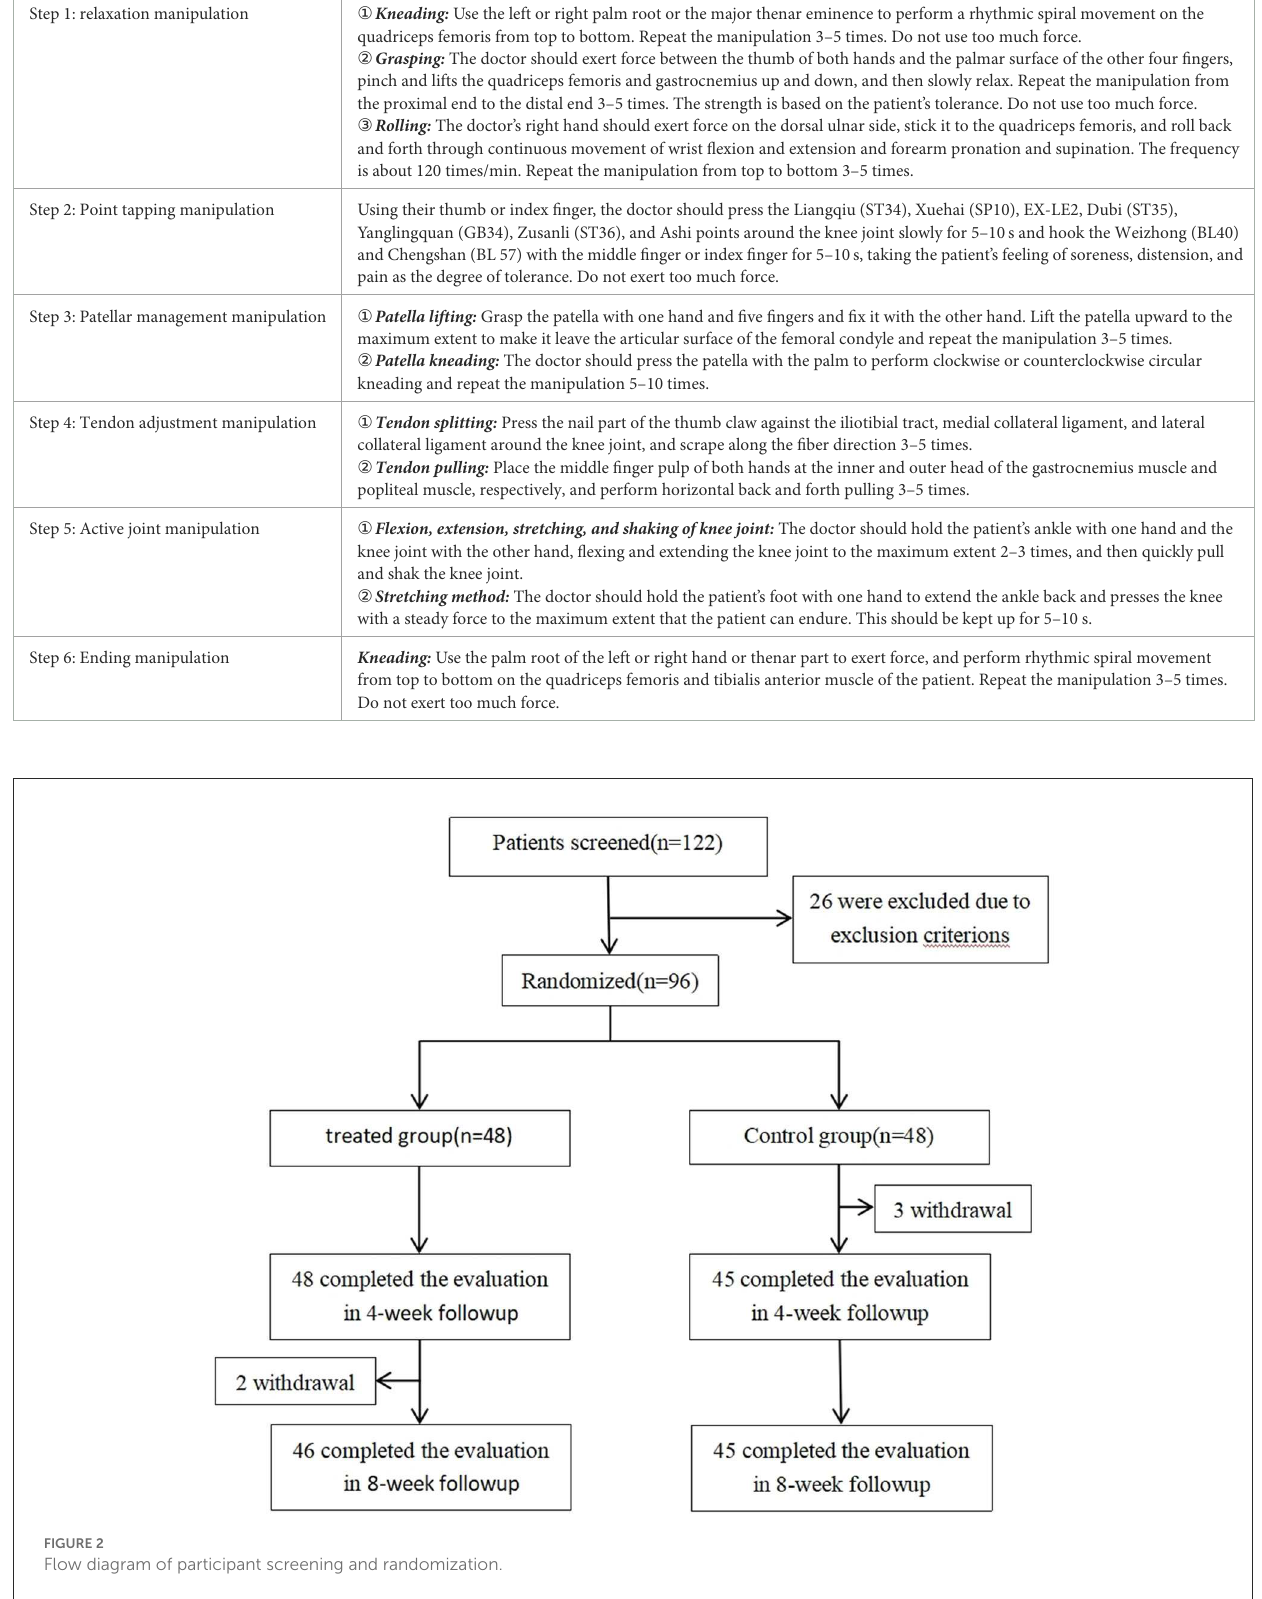
TABLE 1 Tuina treatment protocol for KOA. Treatment position: The patient lies on their back with relaxed lower limbs. The doctor stands on the affected side.